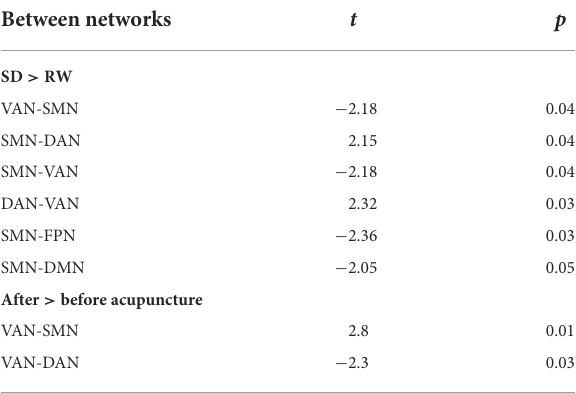
TABLE 4 Large scale between-network FC